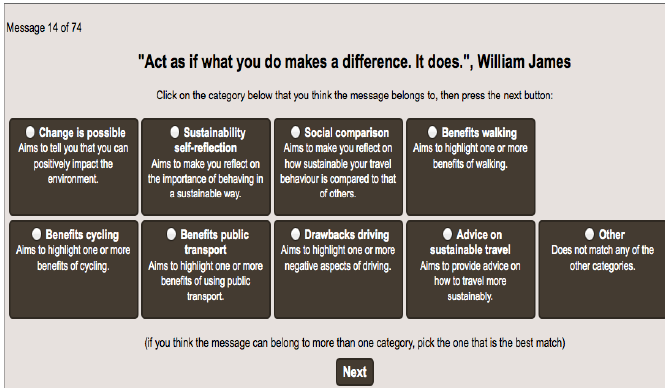
Figure 1. Example of how messages were presented to participants during the MT study, message statement presented at the top of the page, participants select a category from the choices